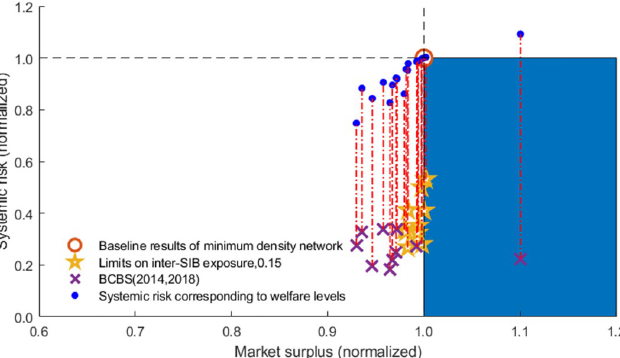
Fig 13. Effectiveness analysis of inter-SIBs exposure limits. The systemic risk and market surplus in the figure are normalized by dividing by the level of baseline results.